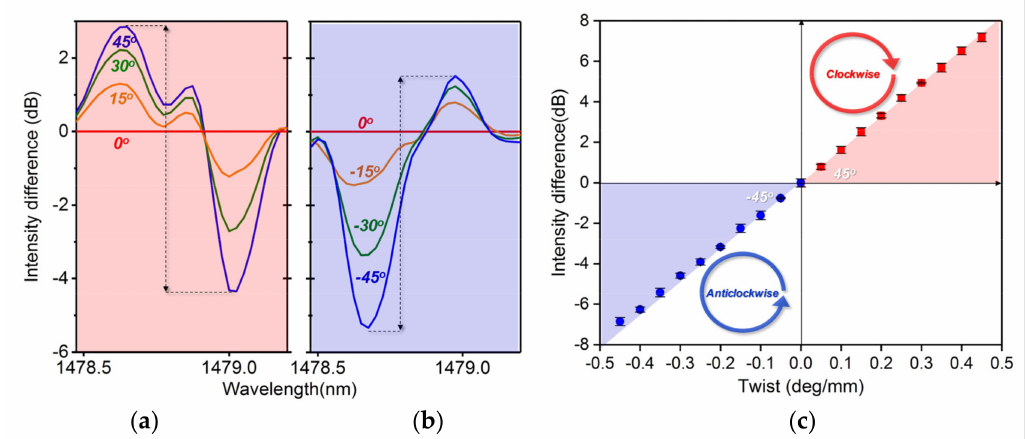
Figure 7. Di ff erential spectrum response to the fiber twist around 1478.6 nm: ( a ) p-polarization; ( b ) s-polarization; ( c ) peak-to-peak intensity response to fiber twist in di ff erent directions.